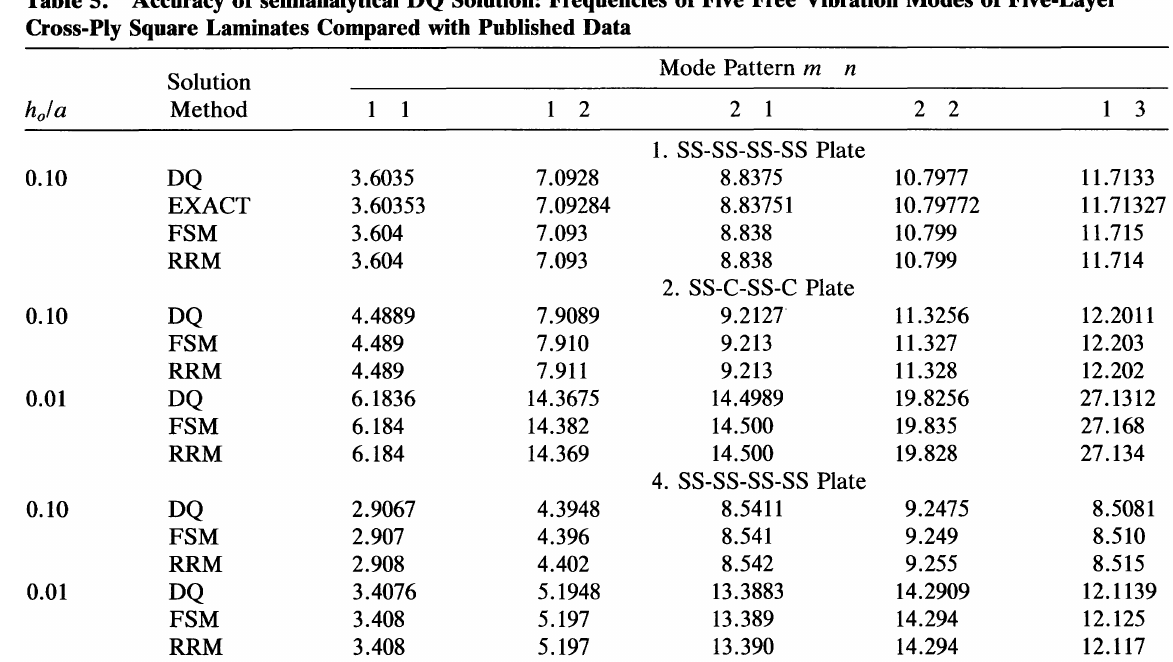
Table 5. Accuracy of semianalytical DQ Solution: Frequencies of Five Free Vibration Modes of Five-Layer Cross-Ply Square Laminates Compared with Published